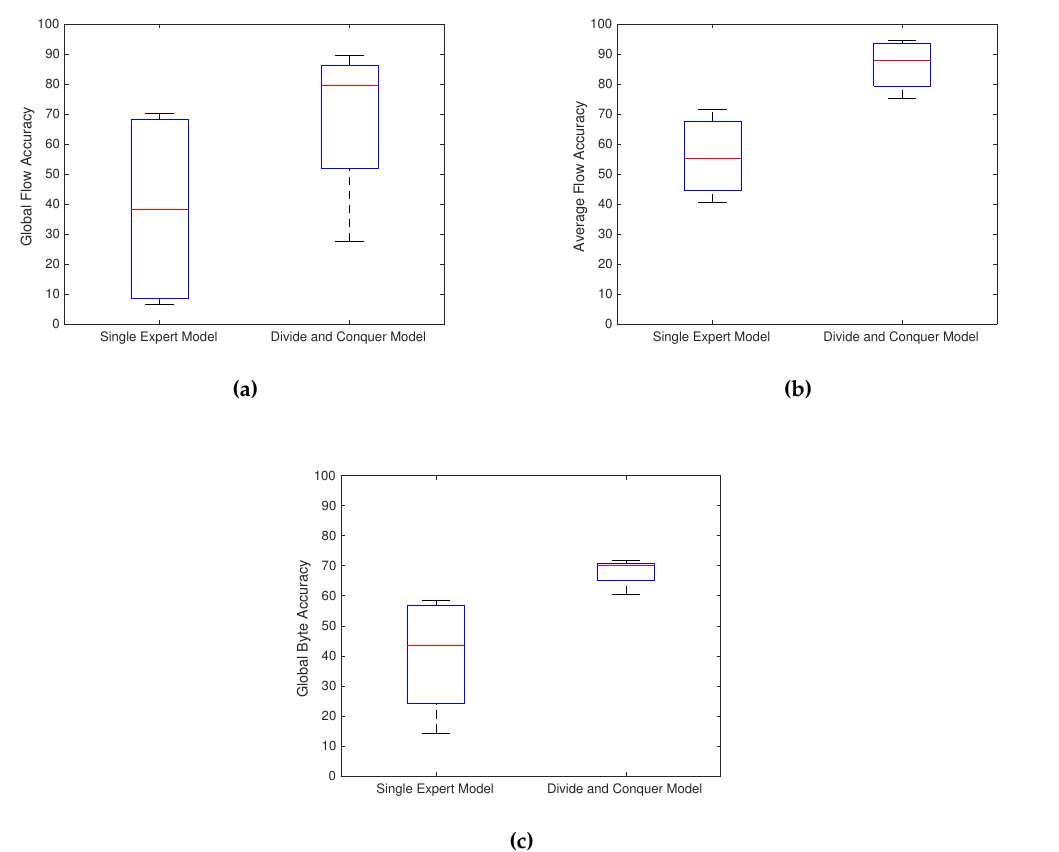
Figure 6. Comparison between a single expert model and a divide and conquer model. The boxplots results for ( a ) Global Flow Accuracy ( GFA ), ( b ) Average Flow Accuracy ( AFA ), and ( c ) Global Byte Accuracy ( GBA ) show the divide and conquer strategy